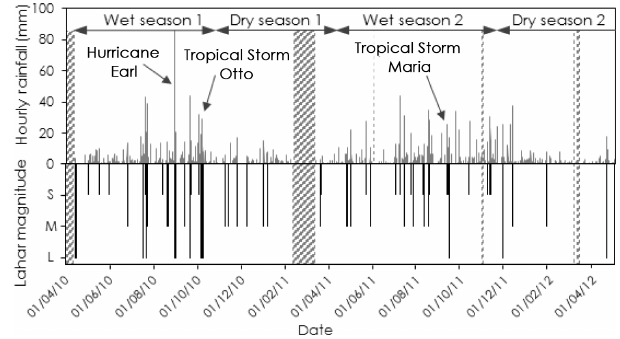
Figure 2. Timeline illustrating hourly rainfall data (above) and rain- triggered lahar activity (below) in the Belham valley, Montserrat, between April 2010 and April 2012 (with minor gaps, stippled or- nament, due to equipment failure). S, M and L on the vertical axis represent small, medium and large lahars respectively; see text for